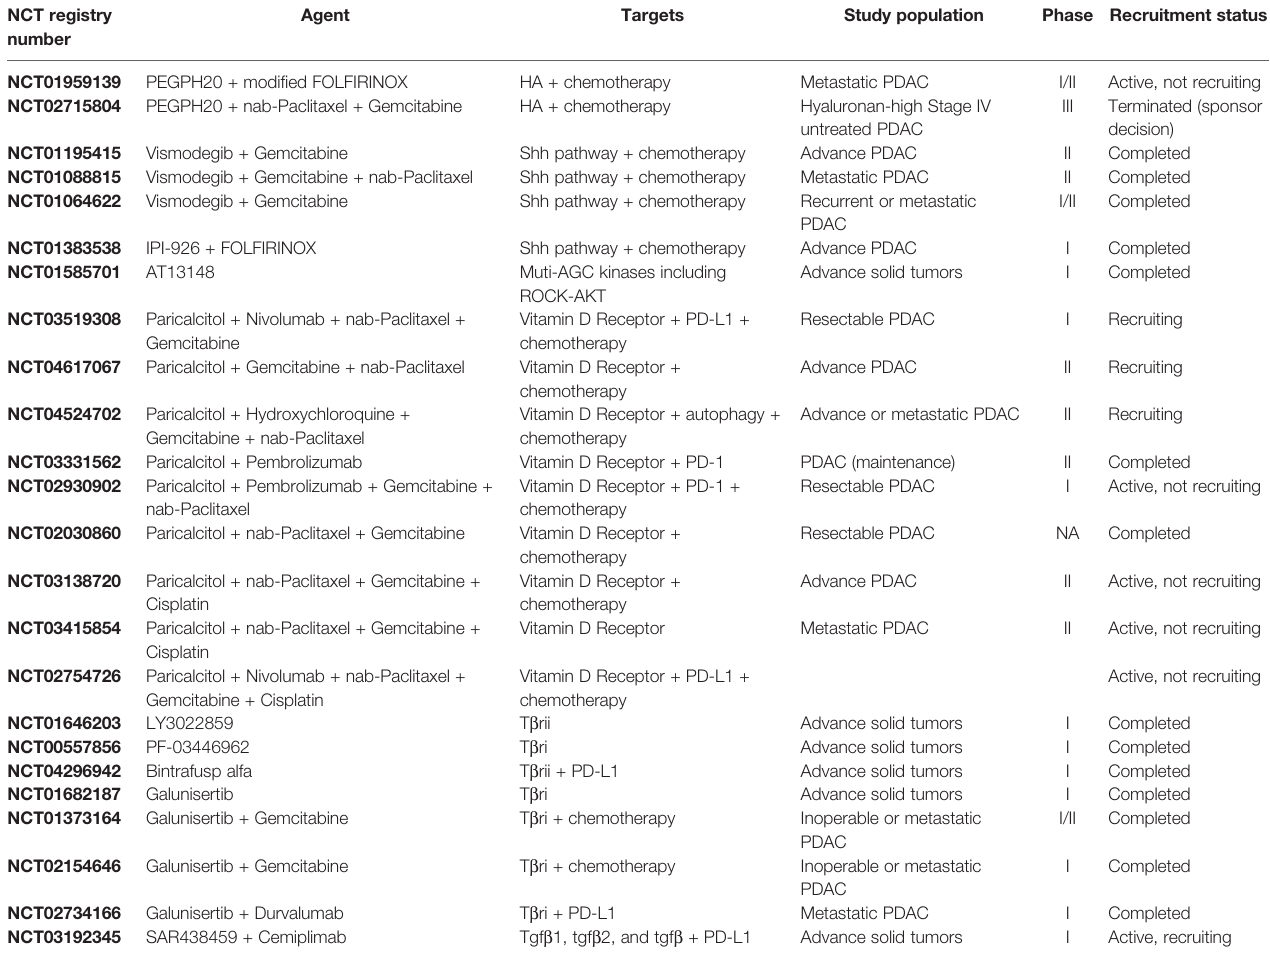
TABLE 1 | Selected clinical trials evaluating stroma and ECM